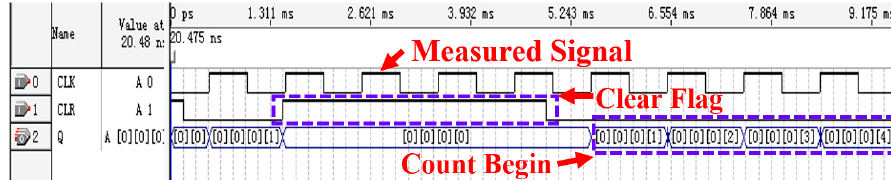
Figure 9. Waveform of counter block cnt.